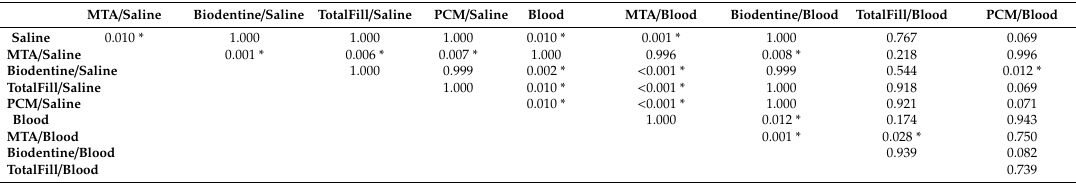
Table 3. p -values obtained from group comparison regarding the interaction of factor material and factor